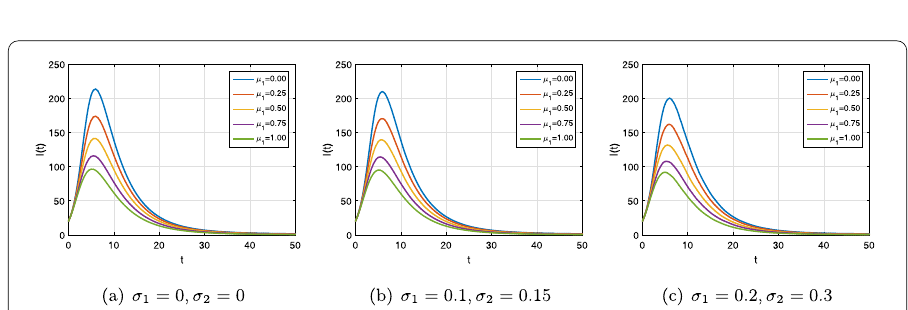
Figure 4 The path of I ( t ) for model (2) with initial ( S 0 , I 0 , R 0 , Z 0 ) = (479.0,20.0,1.0,10.0) under different noise intensities